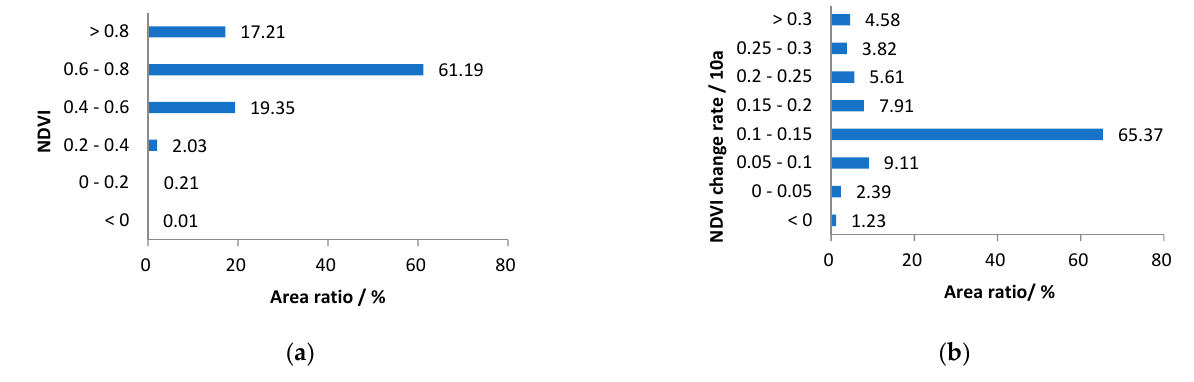
Figure 7. Change trend of NDVI in Qin Mountains (1981–2018).